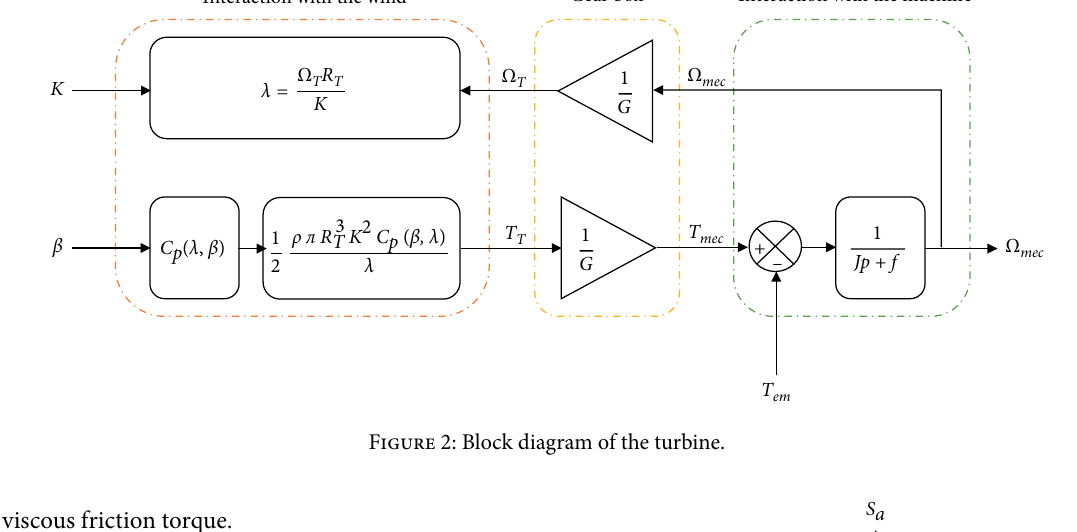
Figure 2: Block diagram of the turbine.